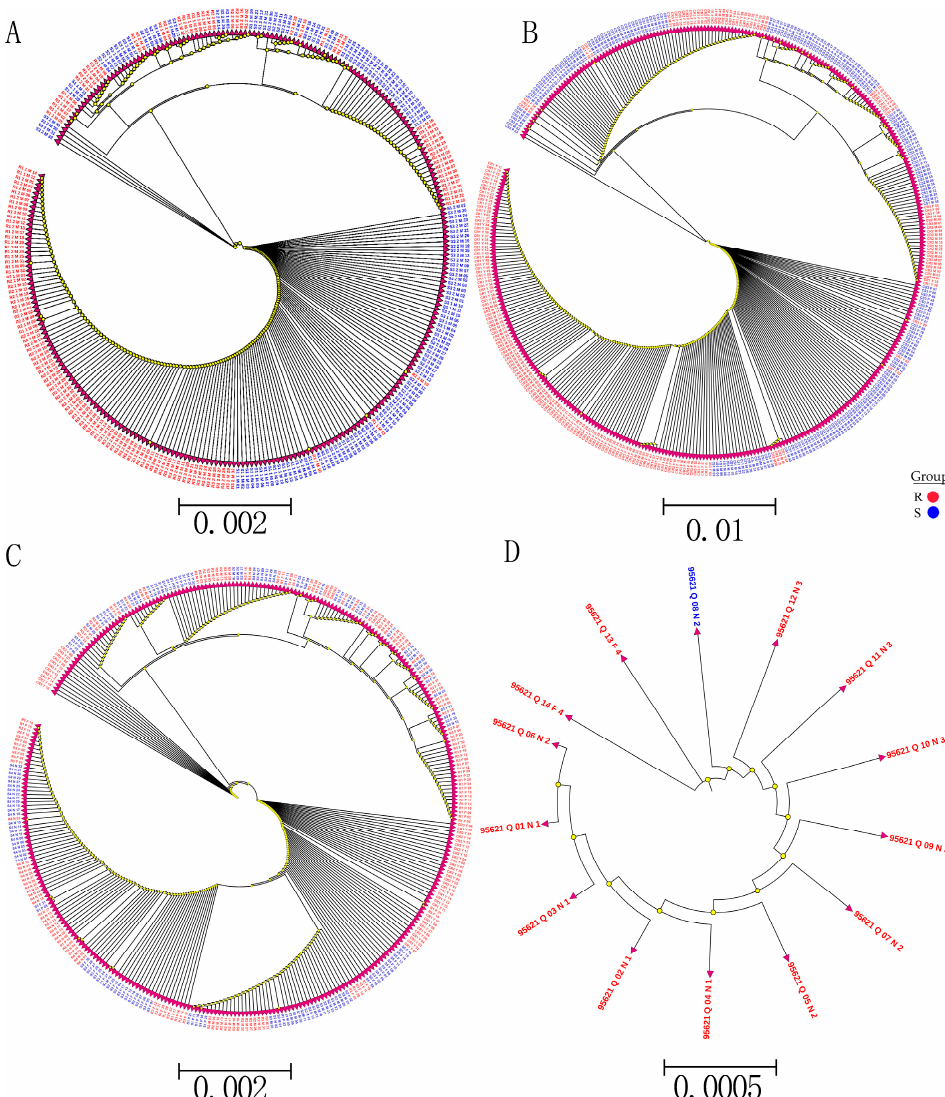
Figure A2. Phylogenetic trees of short DNA Sanger Sequencing of SNP KZ288479_95621 from 1022 samples in different categories. ( A ) Phylogenetic tree of first and second SNP validation of R (resistant) and S (susceptible) of 288 samples from three Apis ceranacerana colonies in Minhou (1 and 2 M); ( B ) comparison of SNP validation of 384 samples from six colonies (three RC (resistant colonies) in Fuzhou and three CS (colonies susceptible) in Minho). ( C ) Further SNP validation of 336 samples from different geographic locations from eight colonies (one colony in Putian (P), one colony in Minhou (M), two colonies in Fuzhou (F), one colony in Nanping (N), and three resistant colonies (CR) in Yunnan Province (Y)); and ( D ) SNP validation at the queen level from 14 colonies (12 colonies in Nanping from three apiaries and two colonies in Fuzhou from one apiary). Neighbor- joining trees were constructed using MEGA 11 software with 1,000-fold bootstrap resampling. After trimming, the numbers at the bottom of each tree represent the different levels of evolutionary relationships between the R and S